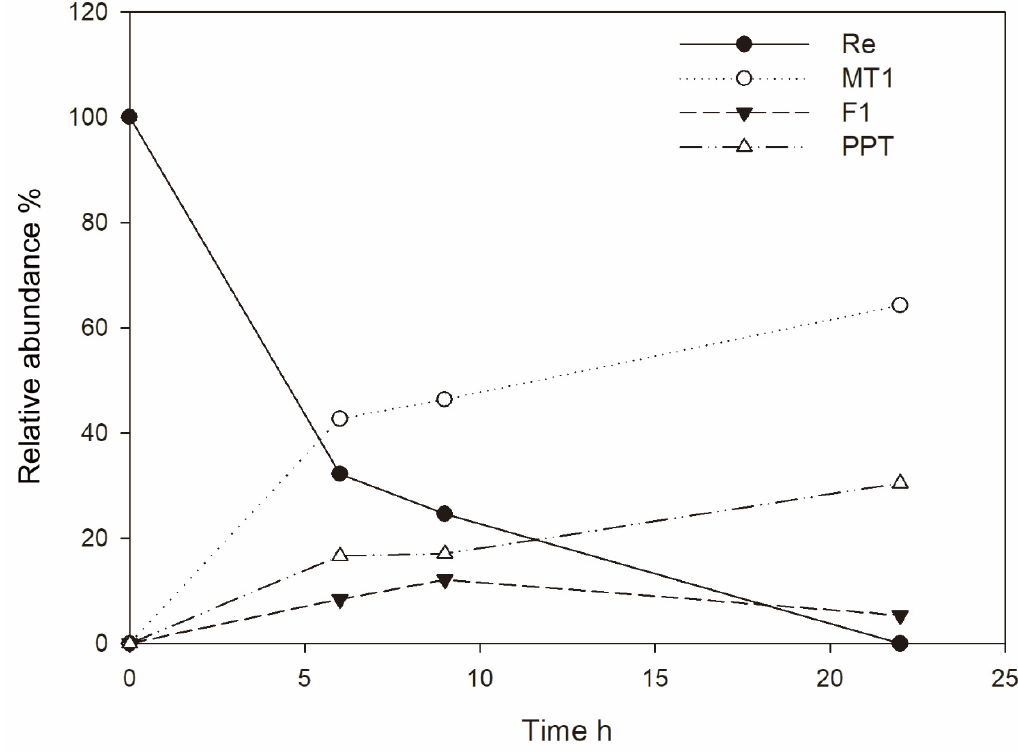
Figure 3. The relative abundance of ginsenosides Re, MT1, F1 and PPT in a scaled-up production reactor over time.